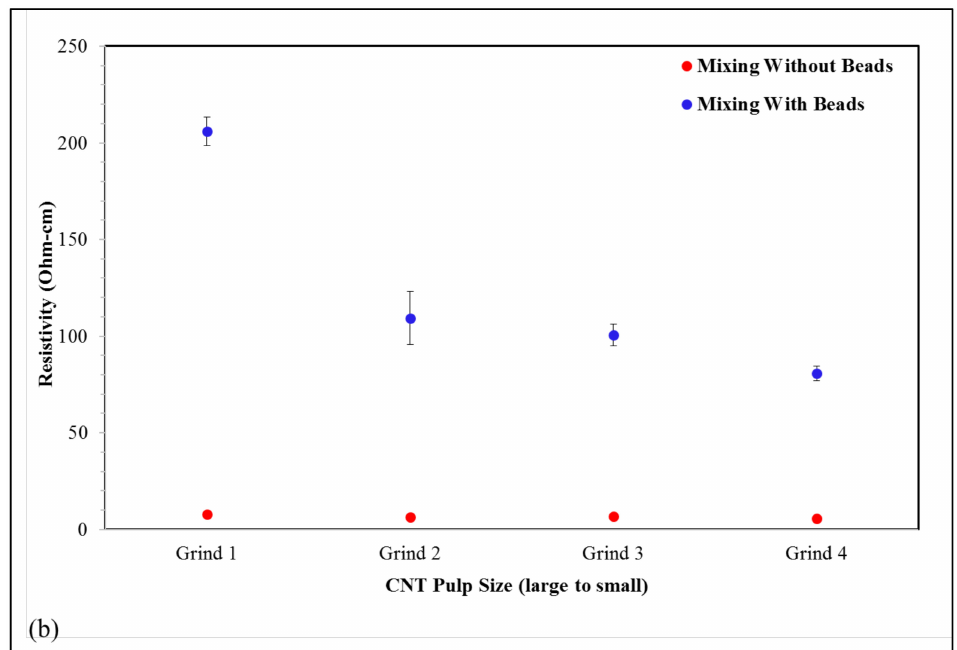
Figure 4. Effect of the use of beads during the CNT and epoxy resin mixing process for ( a ) 0.014% and ( b ) 0.75% wt CNT epoxy composites. Figure 4a shows also the measured resistivity as a function of applied current (5 µ A, 10 µ A, and 100 µ A) at 0.014% wt CNT loading while grind sizes effect on samples containing 0.75% wt CNT is included in Figure 4b.